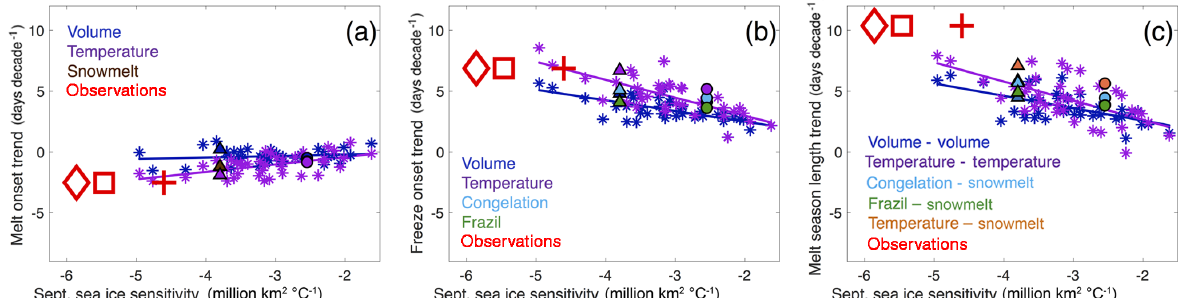
Figure 12. Trends in melt season characteristics versus trends in September sea ice sensitivity from 1979 to 2014 for PMW observations and all available CESM LE ensemble members. Each marker represents an ensemble member. Circles represent ensemble member 34 and triangles represent ensemble member 35. The red markers represent the PMW melt and freeze onset observations and sea ice sensitivity derived from HadCRUT (square), GISTEMP (+) and NCDC (diamond) global temperature observations and NSIDC September sea ice extent (Fetterer et al., 2017). (a) Trends in melt onset using the surface temperature, thermodynamic ice volume tendency and snowmelt definitions. (b) Trends in freeze onset using the surface temperature, thermodynamic ice volume tendency, frazil ice growth and congelation ice growth definitions. (c) Trends in melt season length using the temperature–temperature, temperature–snowmelt, volume–volume, frazil– snowmelt and congelation–snowmelt definitions. Lines represent the least-squares linear